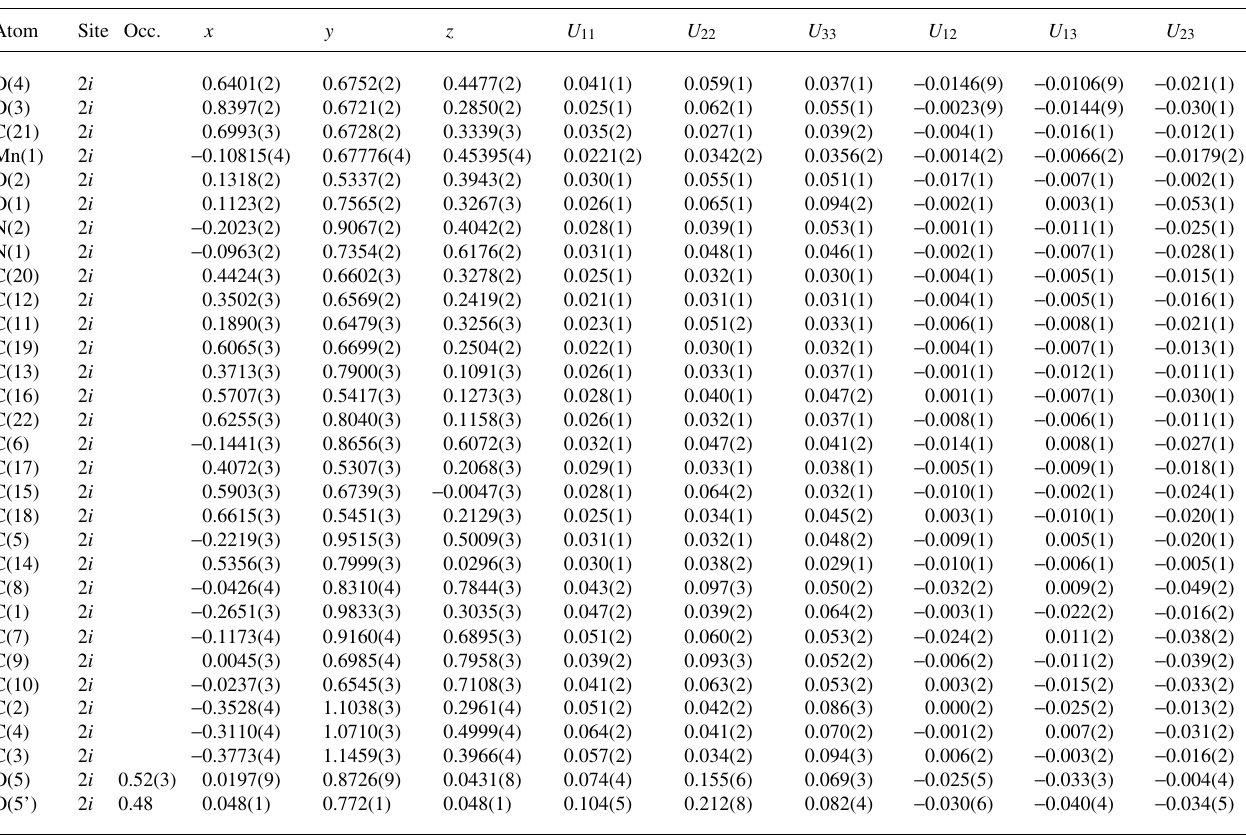
Table 3. Atomic coordinates and displacement parameters (in Å 2 ) .